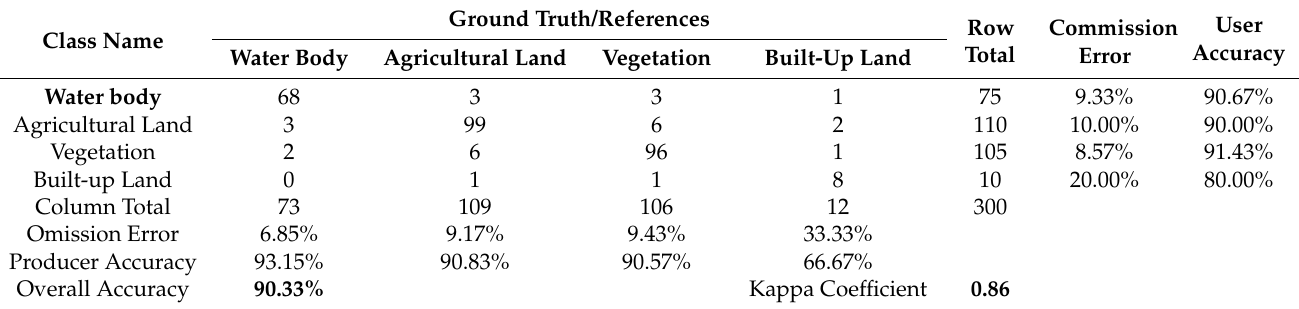
Figure 5. Agricultural Land dynamic in different time periods. Table 5. Accuracy assessment and kappa coefficient in the year of